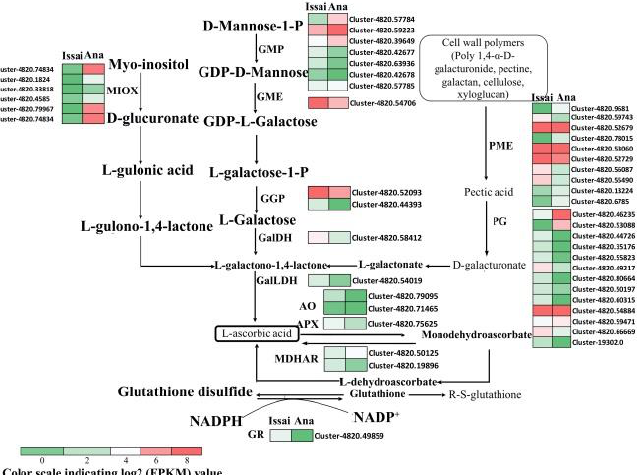
Figure 6. Schematic of AsA metabolism pathway in Ana and Issai. Expression patterns of DEGs are represented by log2 FPKM value and shown as a heatmap at the side of each step. The cells of the heatmap from left to right represent the expression level in Issai and Ana, respectively. The full name of the abbreviated genes is listed in the Table